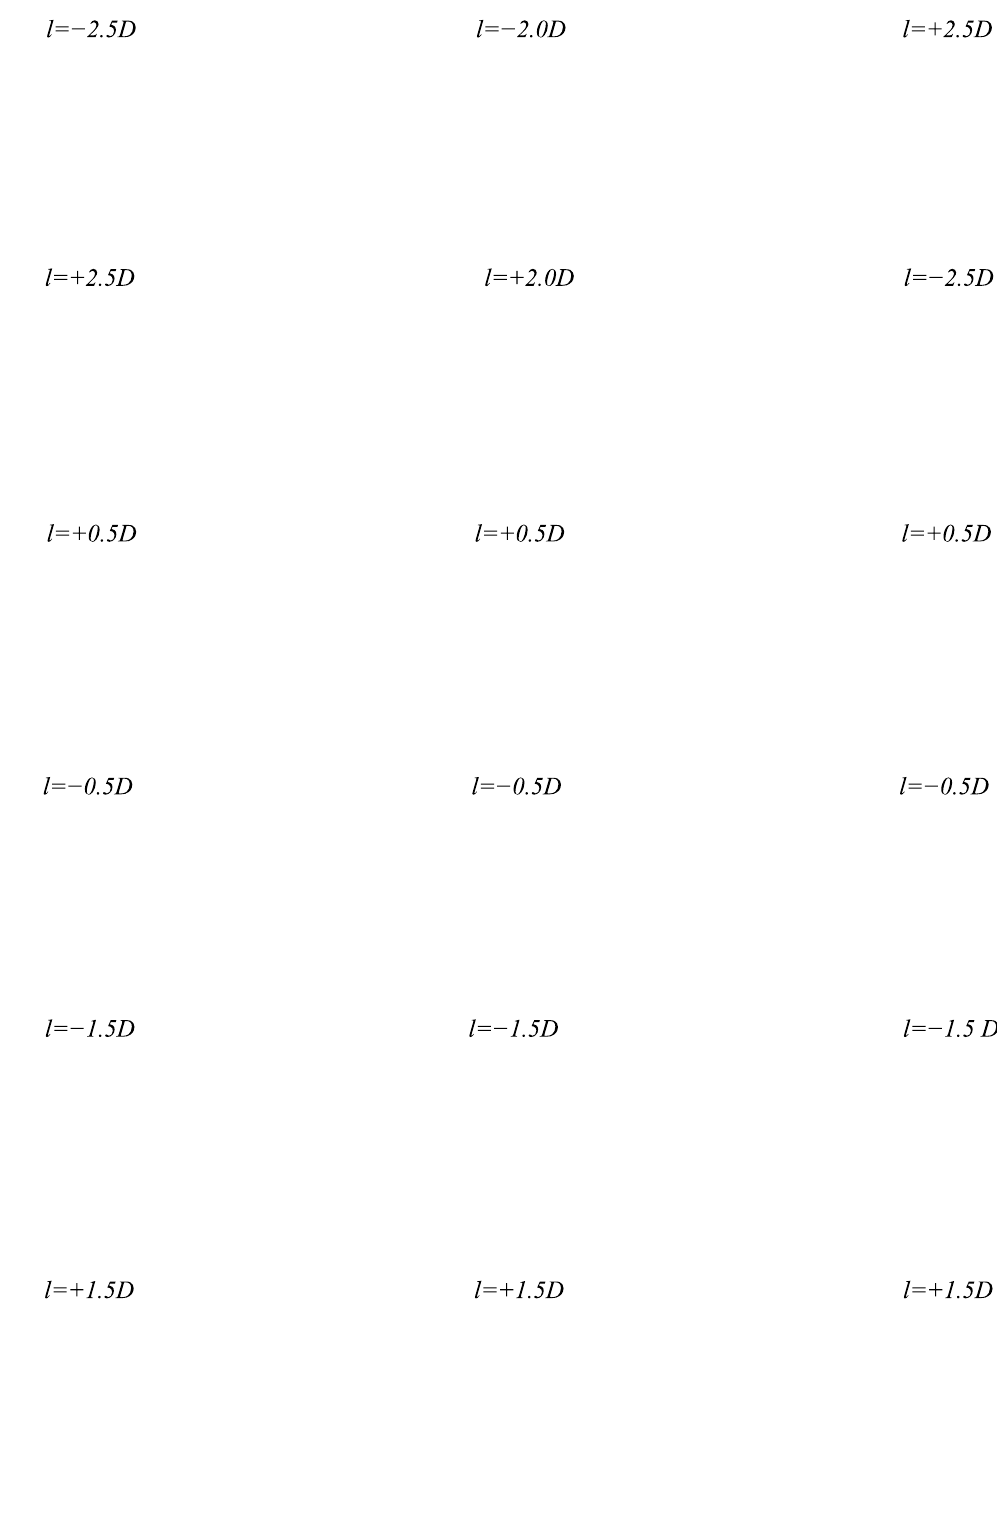
Figure 11. The velocity field on the wake side of the cylinders. The wakes are extracted by using a threshold filter on the pressure within 10 to 100